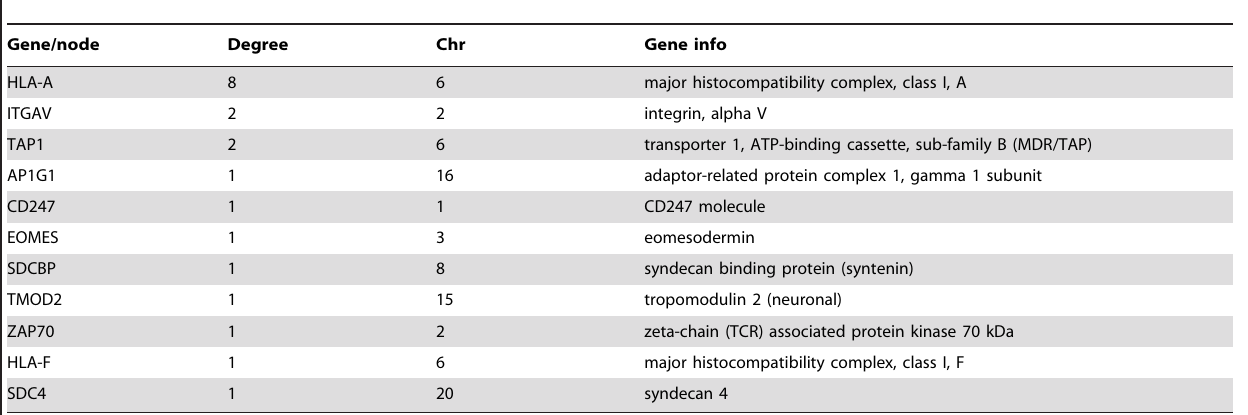
Table 8. Immune module: gene/node